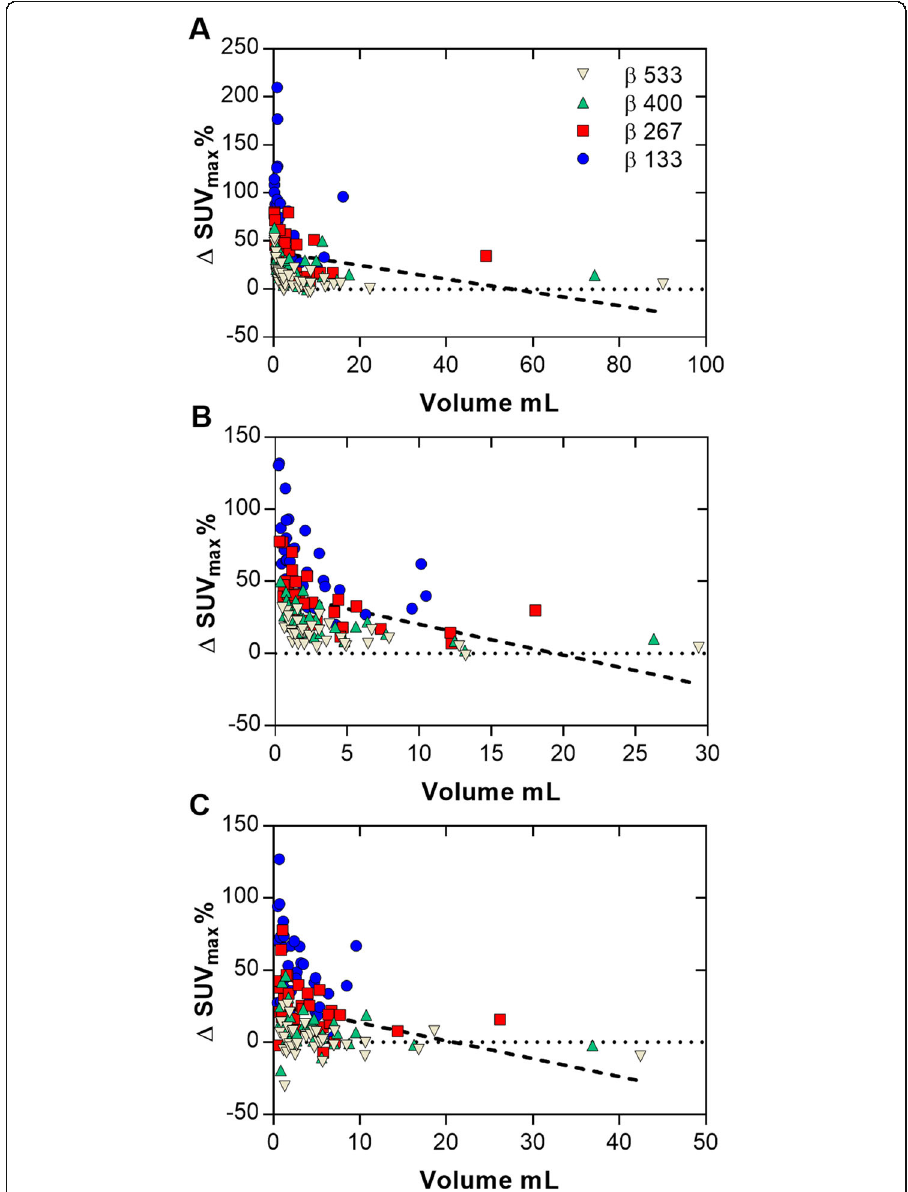
Fig. 5 Plots showing the relative increase of SUV max in lesions for BSREM with β -values of 133, 267, 400, and 533 compared with OSEM (3 iterations, 16 subsets, 5-mm Gaussian post-processing filter) over lesion volume, for 68 Ga-DOTATOC ( a ), 18 F-fluoride ( b ), and 11 C-acetate ( c ). Both reconstruction methods included TOF and PSF recovery. Dashed lines indicate the linear regression of the respective cohort (for all β